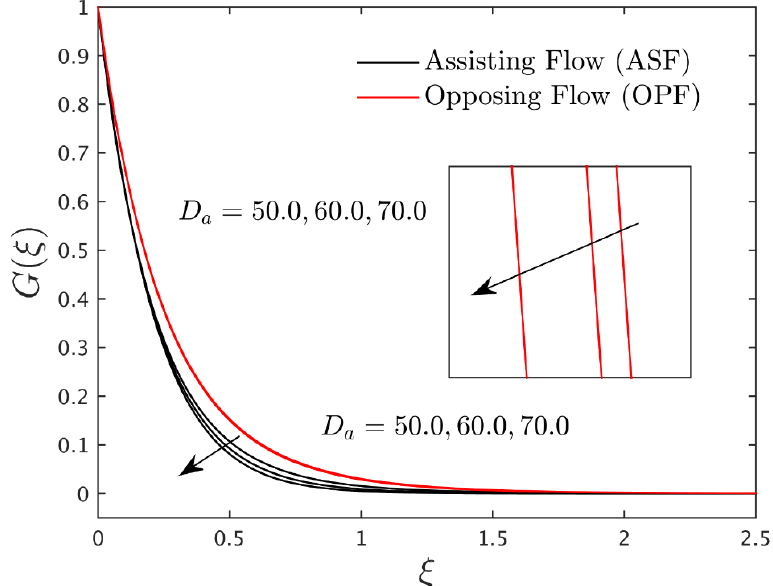
Figure 5. Temperature profile for the case of ASF and OPF due to variations in the values of D a .